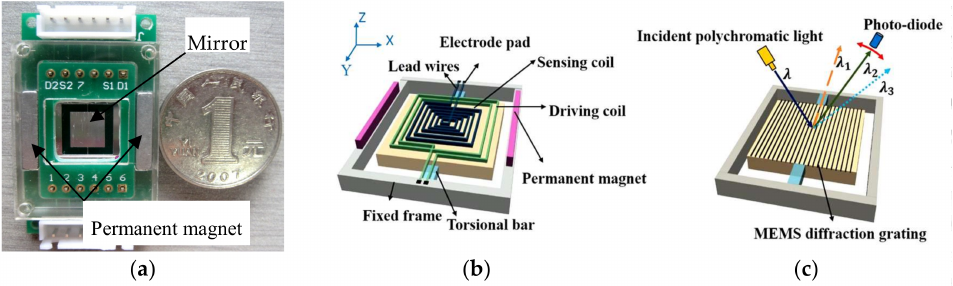
Figure 2. The Micro Opto Electro Mechanical Systems (MOEMS) scanning grating mirror fixed on the Printed Circuit Board (PCB) frame: ( a ) the fabricated scanning grating mirror, ( b ) the driving and angle sensing coils on the lower side and ( c ) the integrated blazed grating on the upper side.